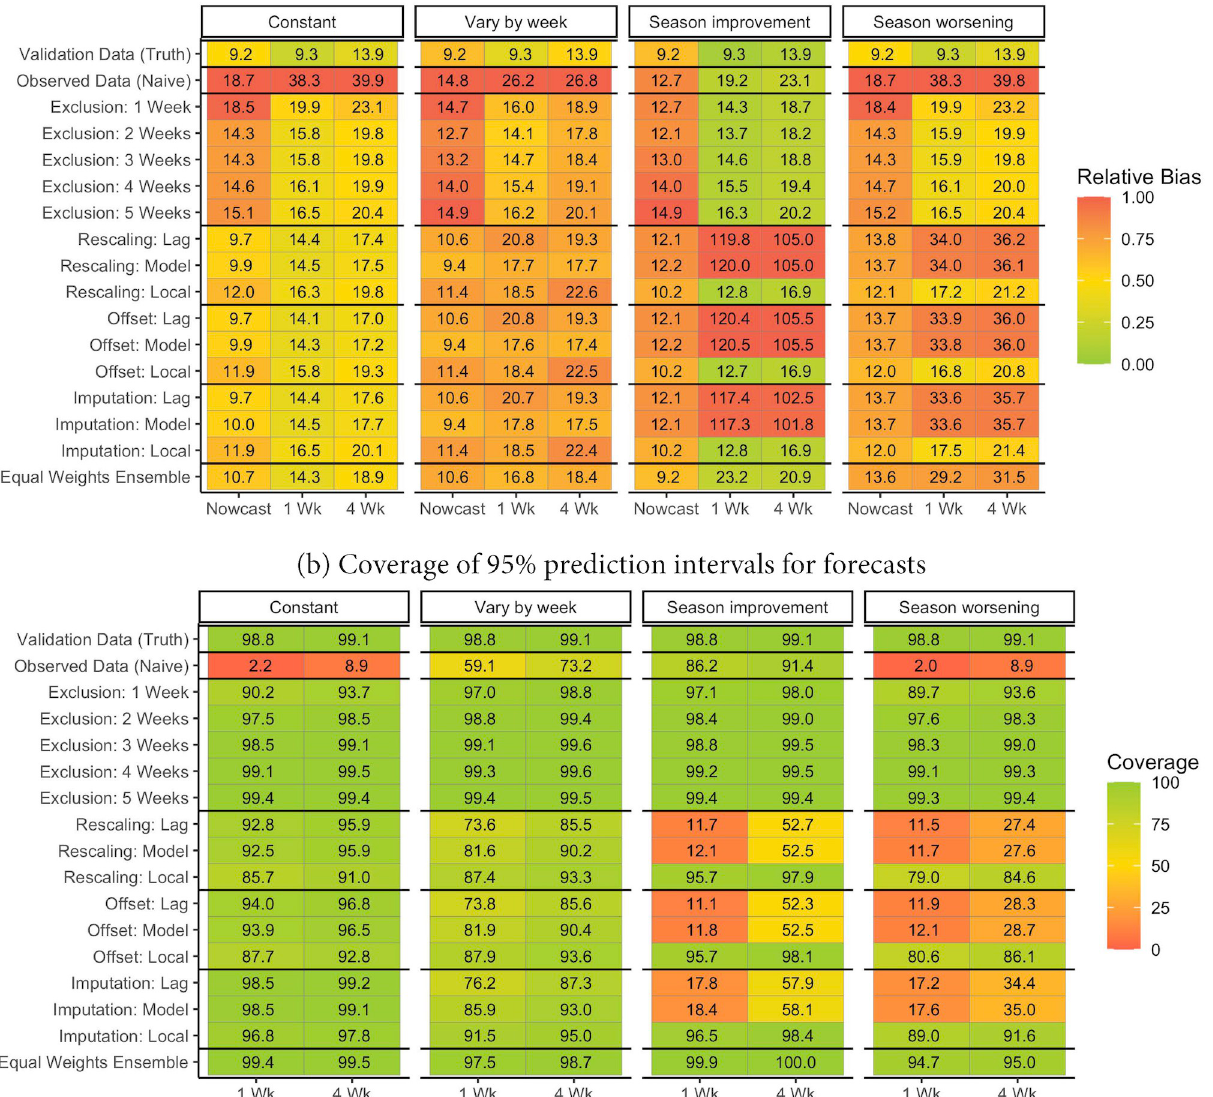
( d ) estimation ts